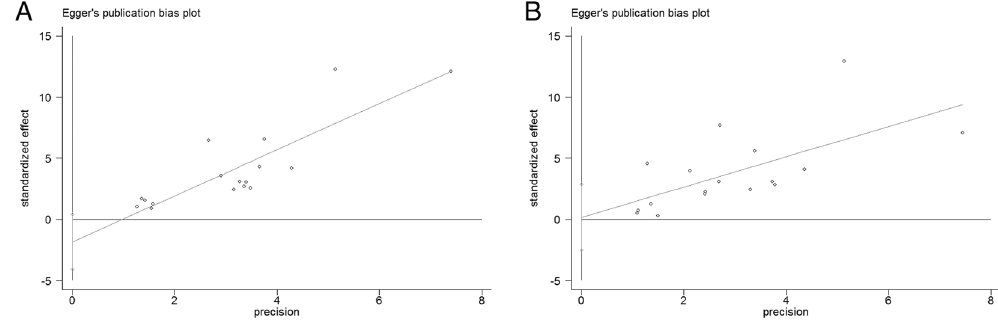
Figure 6. Publication bias analyses (Egger’s test) for the pooled effect